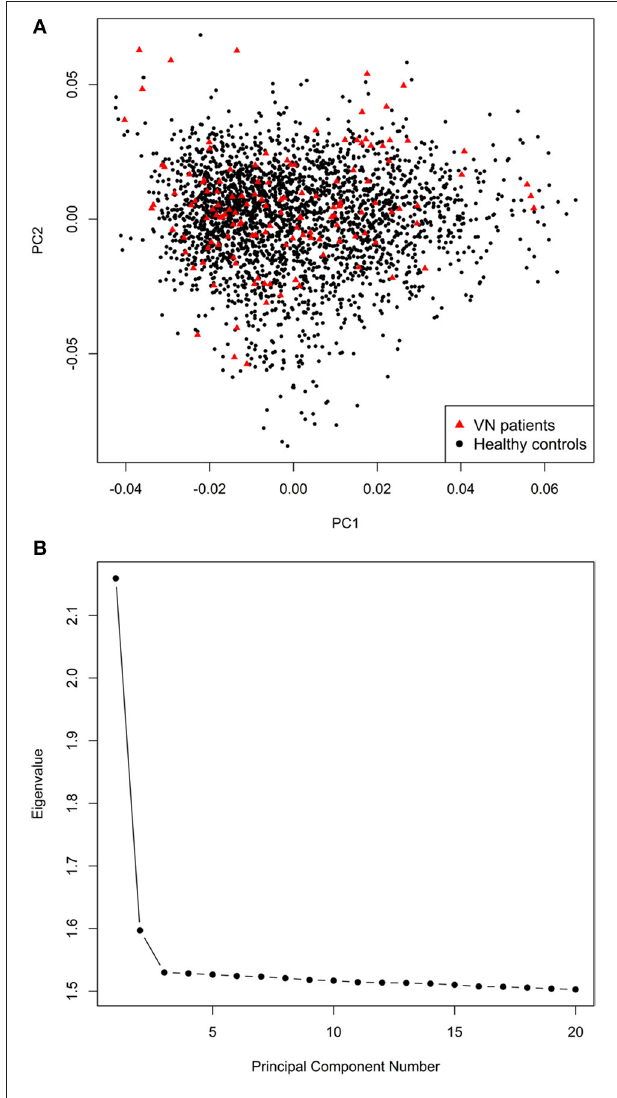
FIGURE 1 | (A) Scatterplot of the first two principal components derived by EIGENSTRAT. (B) Scree-plot of principal components 1–20 derived by